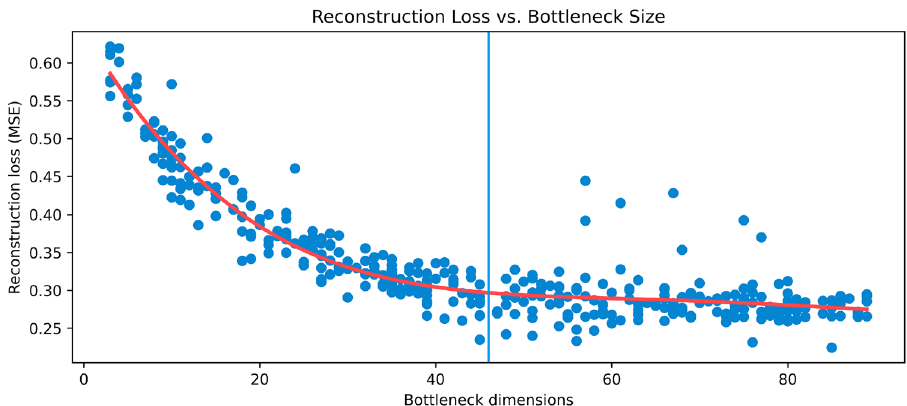
Figure 8. Bottleneck size experiment. Reconstruction loss decreases with increasing size of the bottleneck. However, once a certain threshold of dimensions is reached (at 46 dimensions), the loss stops improving rapidly and only slowly decreases when adding more dimensions to the bottleneck. In red, we show a polynomial of degree 4 that was fit on the data for illustrative purposes. Note that odd bottleneck sizes are rounded up (e.g., 45 becomes 46) to create an even-dimensional feature space for downstream